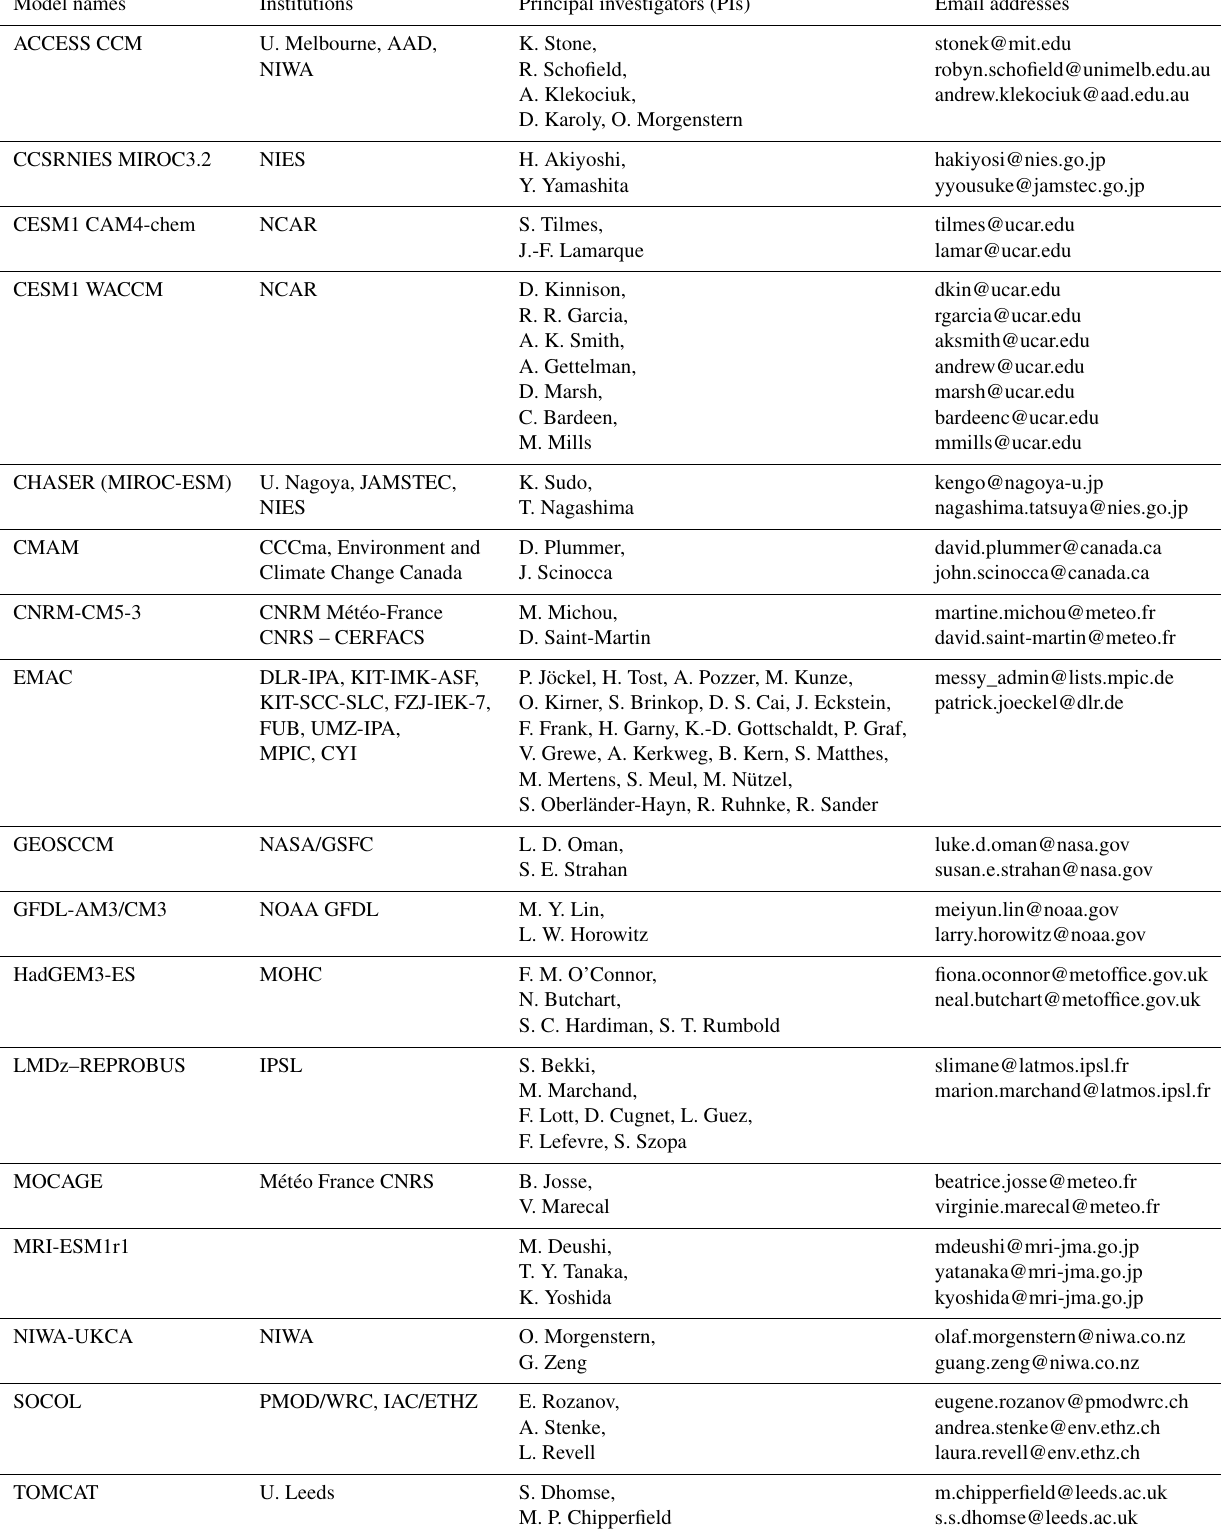
Table 1. Participating models and contact information. For abbreviations of institution names, see the authors’ affiliations. Model